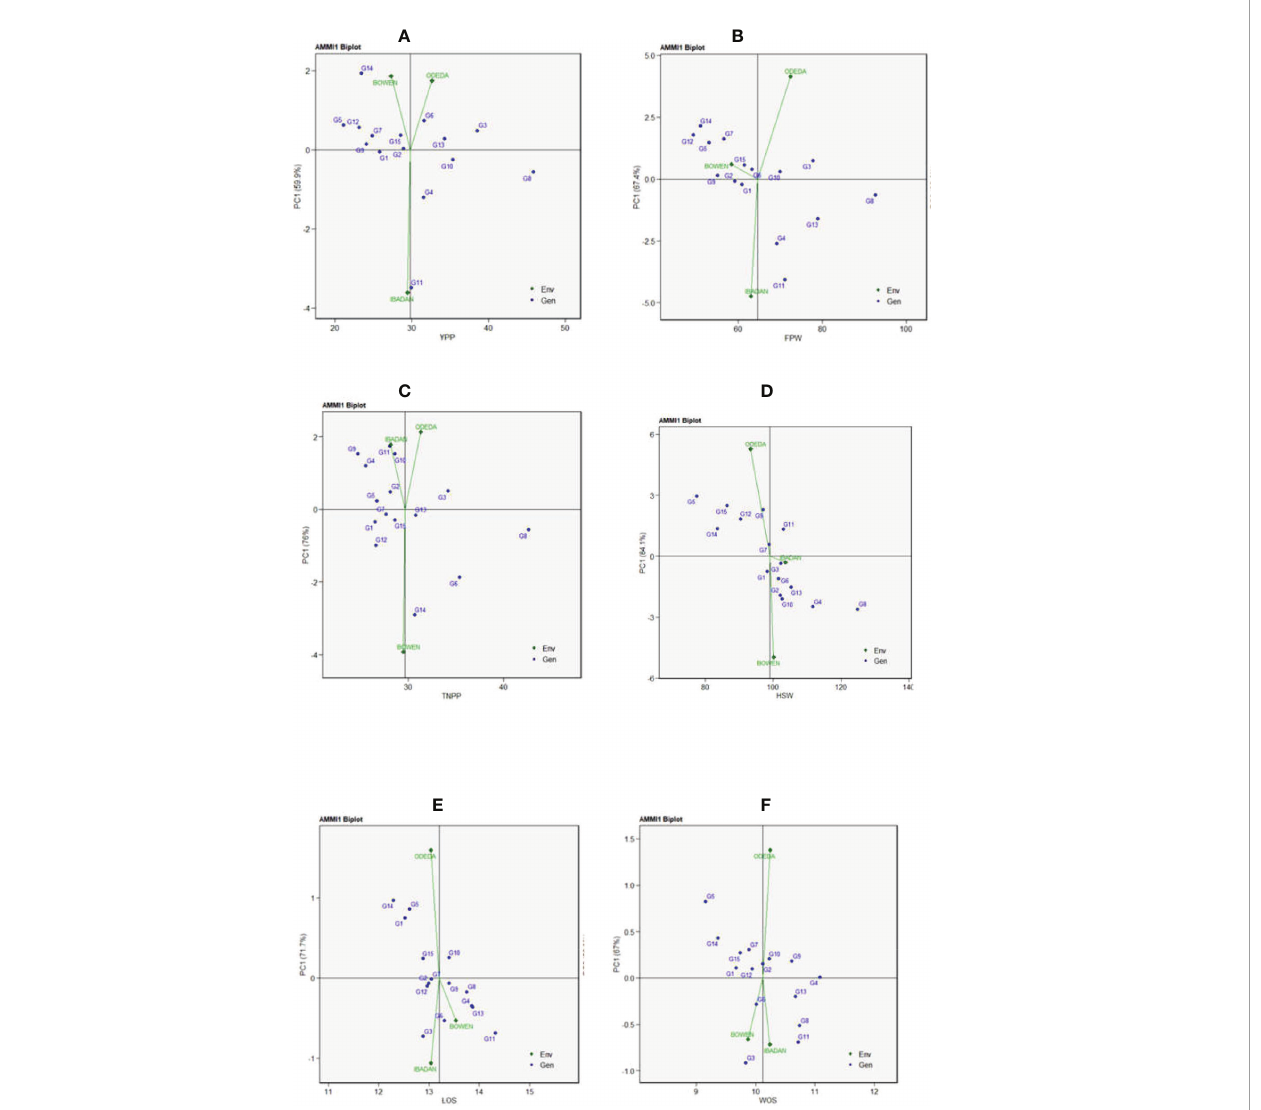
FIGURE 1 Patterns (A – F) . Additive main effects and multiplicative interaction 1 (AMMI 1) biplots based on PC1 illustrating G × E interactions of the 15 Bambara groundnut accessions under three sites: (A) yield per plant (YPP), (B) fresh pod weight (FPW), (C) total no. of pods per plant (TNPP), (D) hundred seed weight (HSW), (E) length of seeds (LOS), and (F) width of seeds